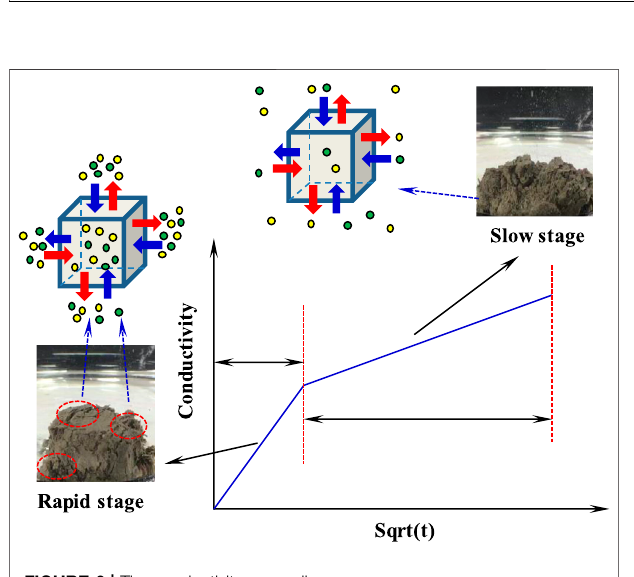
FIGURE 5 | The conductivity curves of different sediments (A) conductivity vs. t and (B) conductivity vs. sqrt (t).